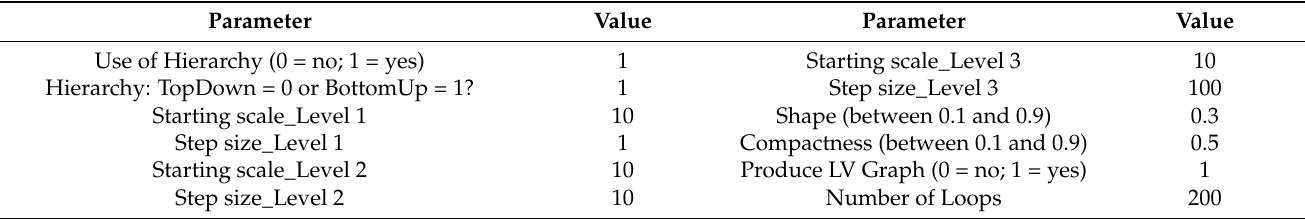
Table 3. Algorithm parameters and settings in the ESP 2